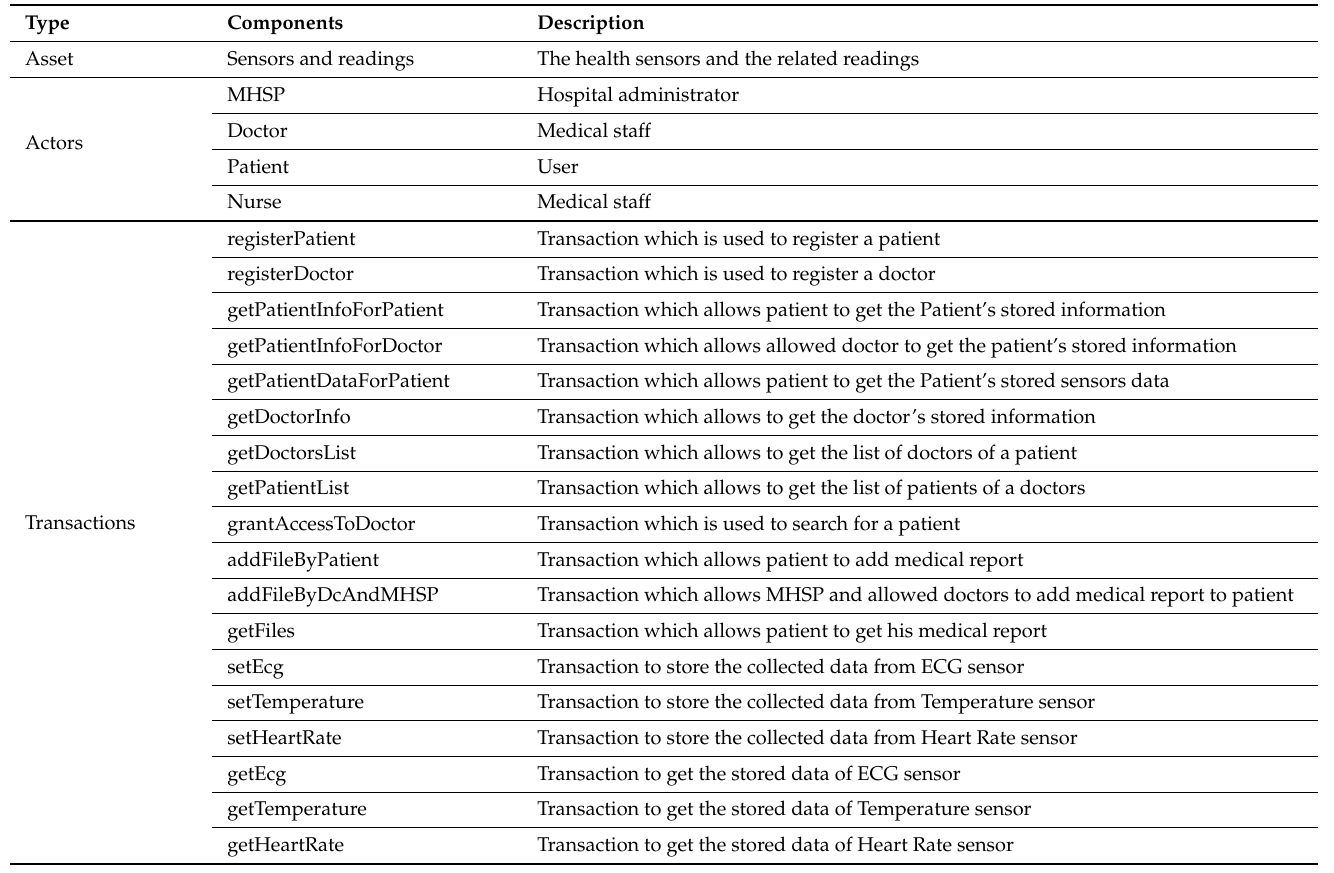
Table 3. Smart Contract for the proposed